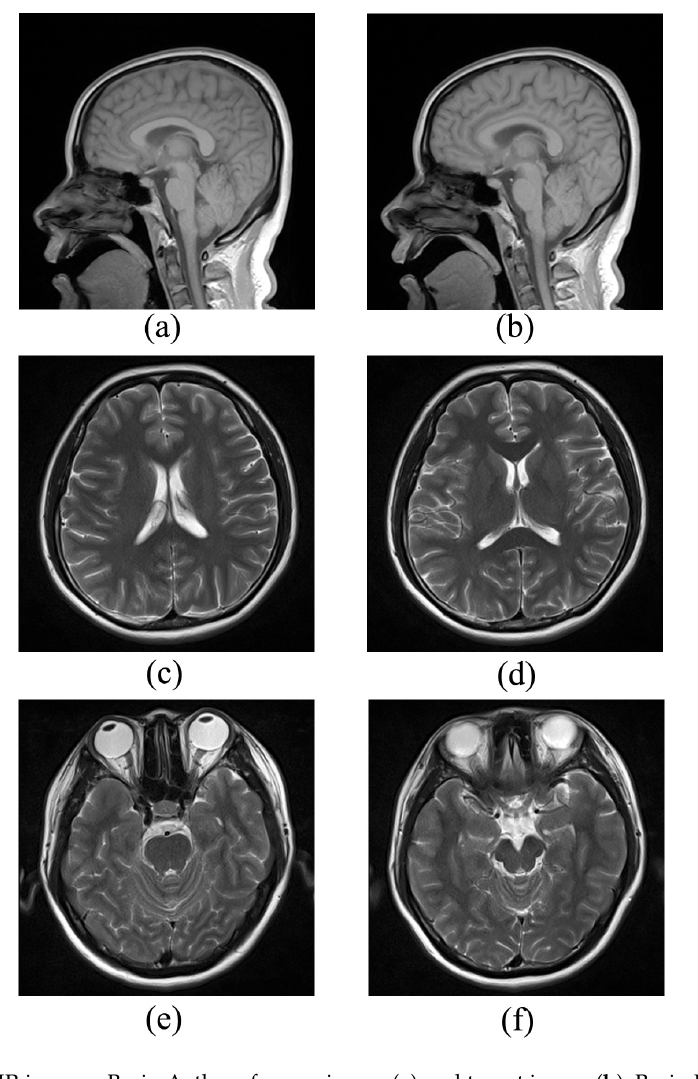
Figure 3. The MR images. Brain A: the reference image ( a ) and target image ( b ); Brain B: the reference image ( c ) and target image ( d ); Brain C: the reference image ( e ) and target image ( f ).